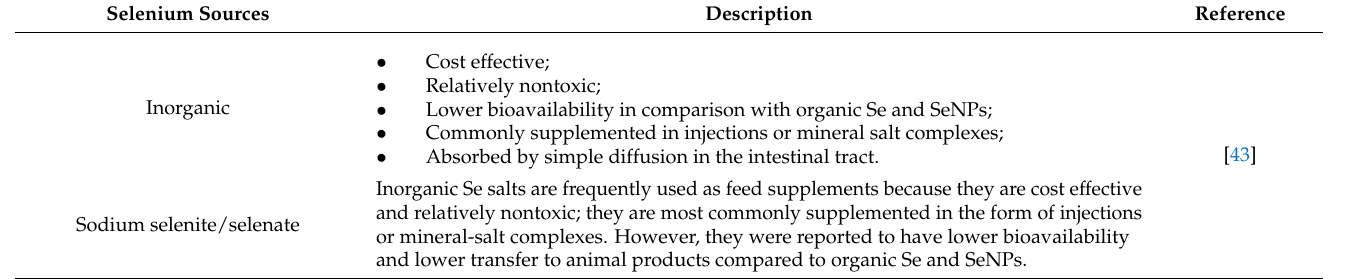
Table 2. List of dietary selenium sources in animal